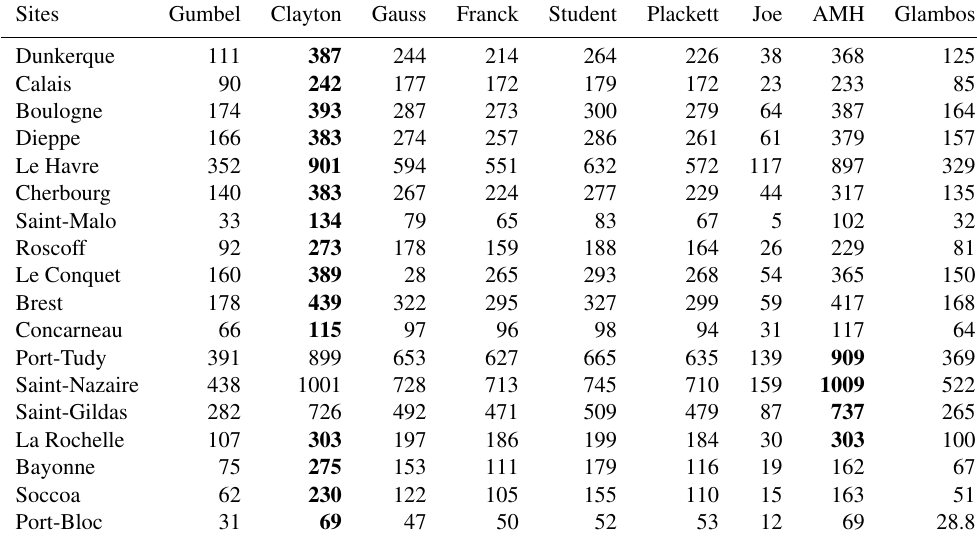
Table C1. Likelihood for 18 French